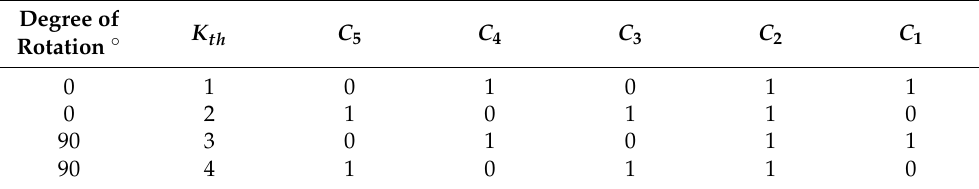
Table 6. Compression of FDW W = 3 for polarization encoding